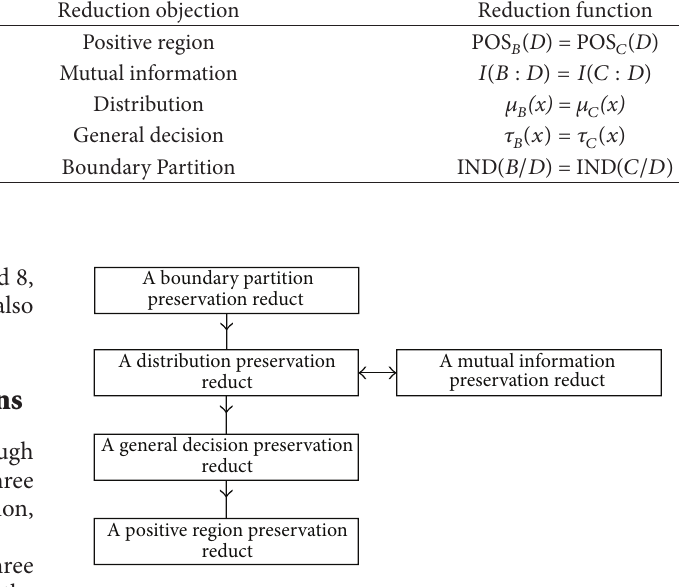
Figure 1: Relations of five relative